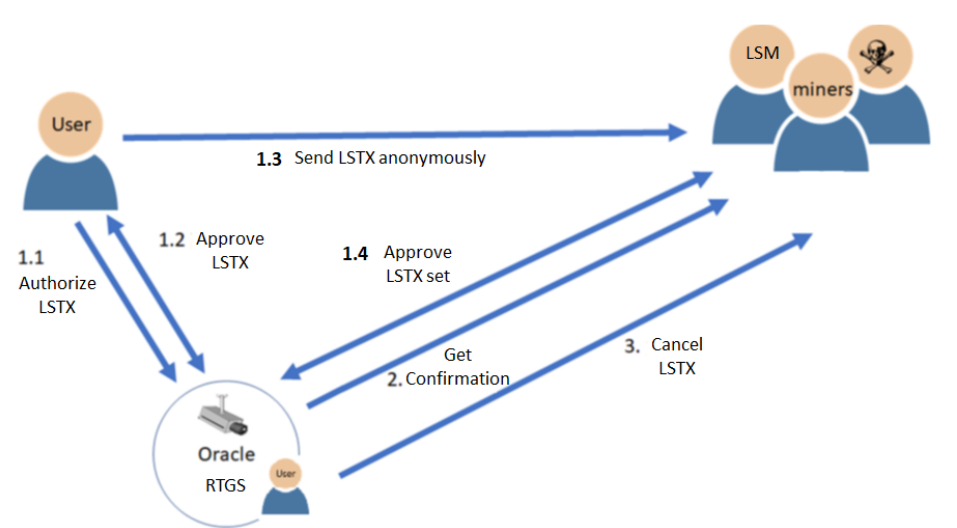
Figure 11. Liquidity saving transactions in